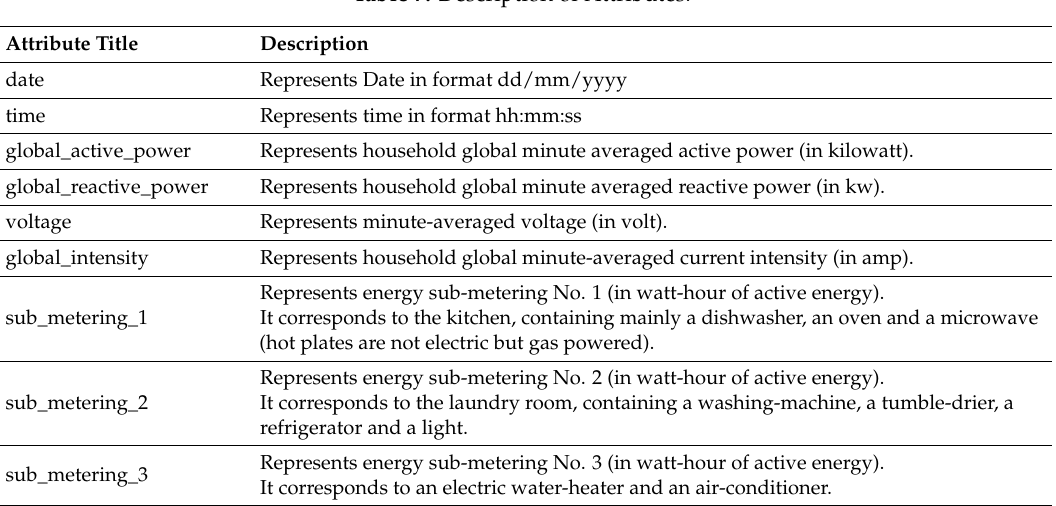
Table 7. Description of Attributes.